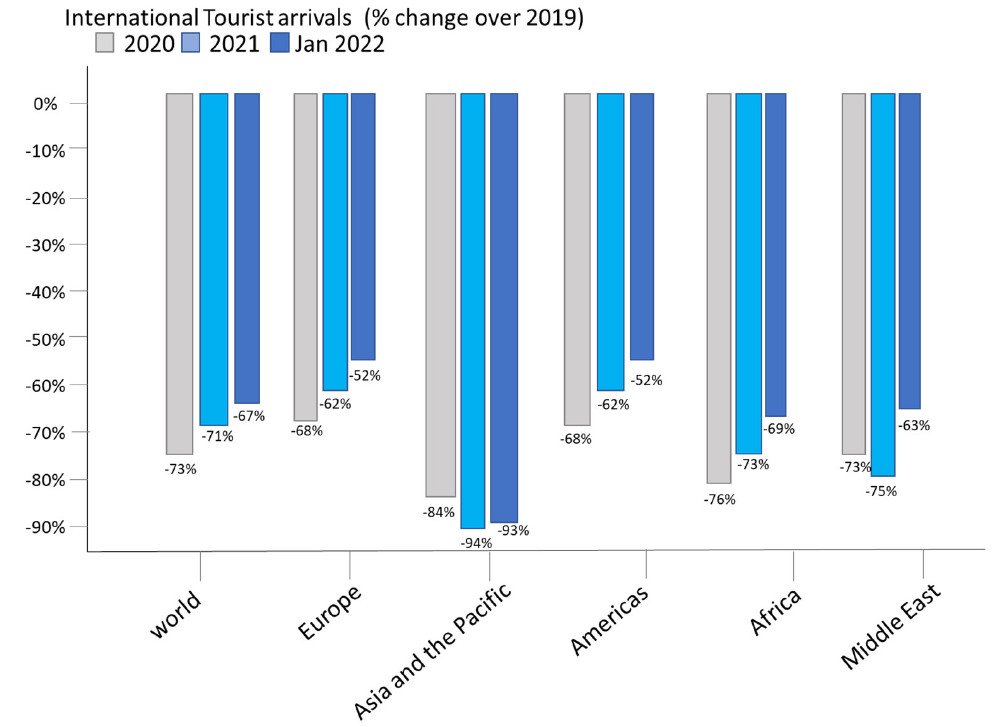
Figure 1. Source: World Tourism Organization (UNWTO). Change over 2019 (provisional data). Data collected by UNWTO, March 2022. Published: 25 March 2022.